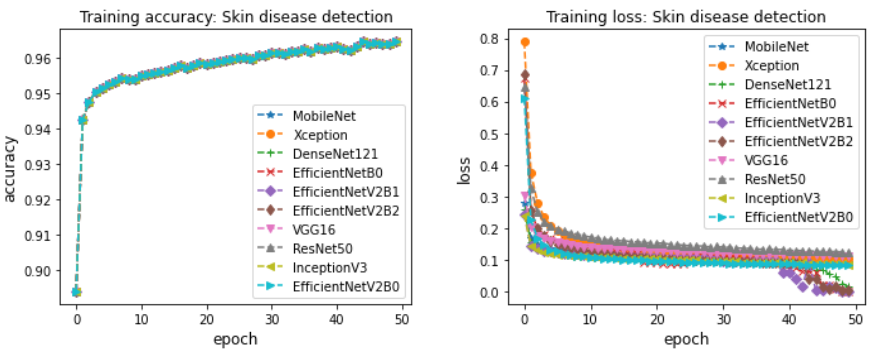
Figure 5. Training accuracy and training loss of CNN-based finetuned models for skin disease detection (left to right).